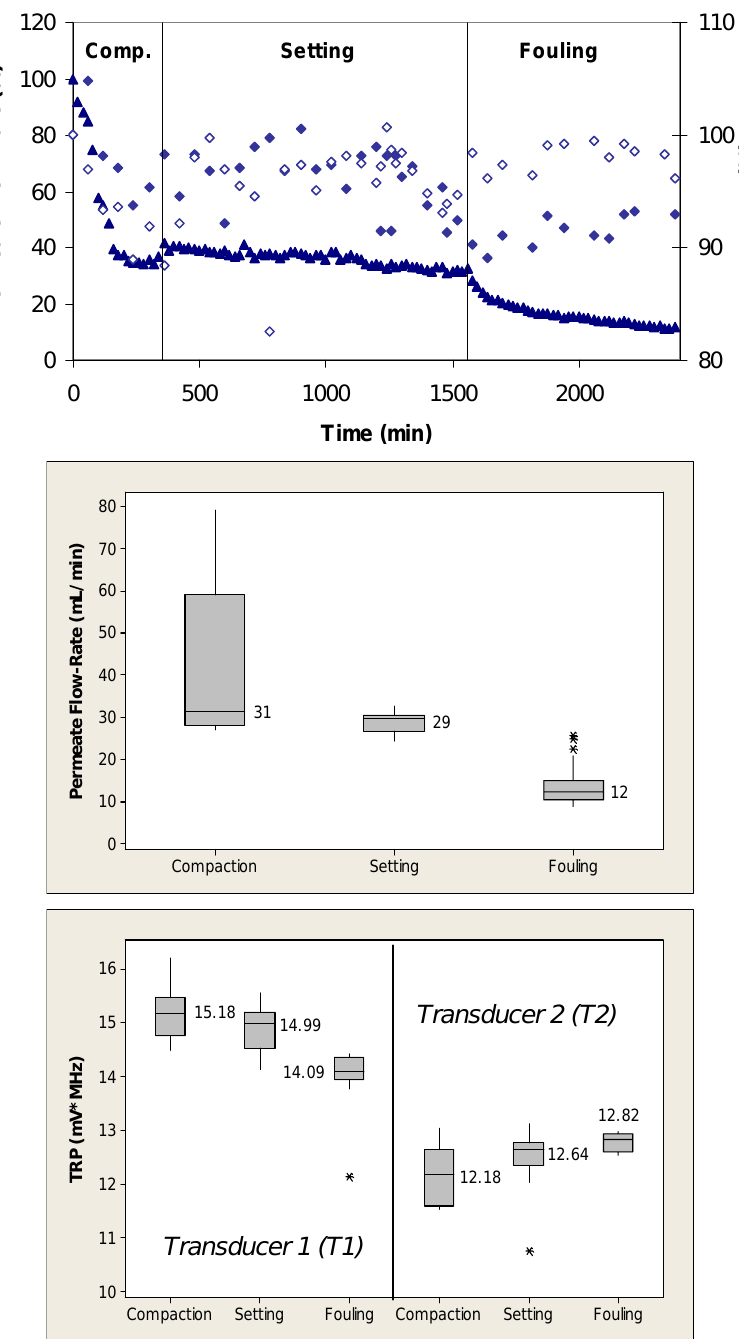
Figure 4. TOP: Permeate flow ( ▲ ) and total reflected power (TRP) from two transducers ( ♦ , ◊ ) associated with compaction, setting and fouling when PS membranes were challenged with 0.1 g/L BSA; maximum standard deviations from at least three independent observations are 6% and 7% for permeate flow and TRP, respectively. MIDDLE: Permeate flow data during the challenge represented in a box plot format where the vertical lines on the boxes indicate minimum and maximum observations; upper and lower quartiles are represented by the box boundaries and the median value is represented by the central intersecting line. BOTTOM: TRP distributions from each of two transducers mounted on the flow cells during the challenge represented in a box plot